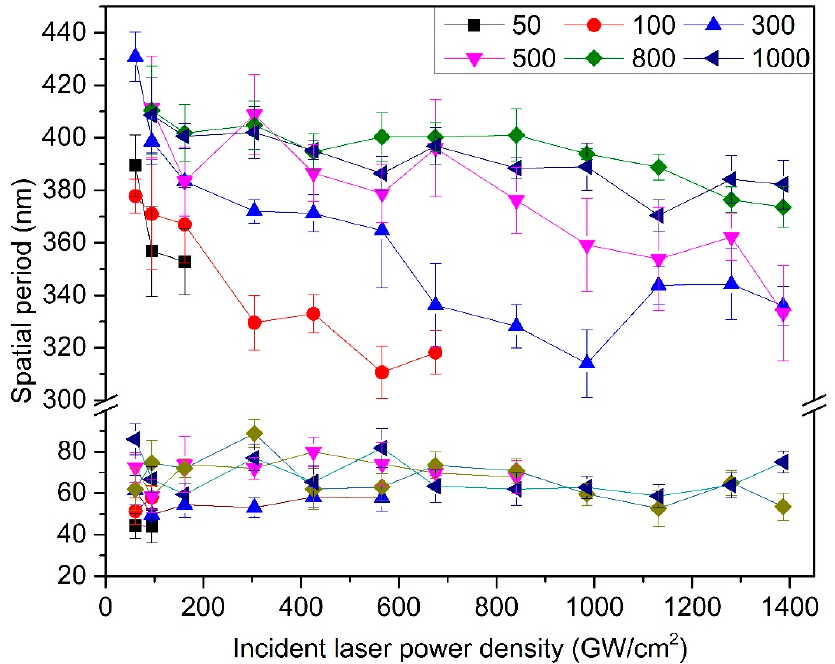
Figure 6. Comparison of the spatial period tendency of NSRs and DSRs with incident laser peak power density and scanning speed.